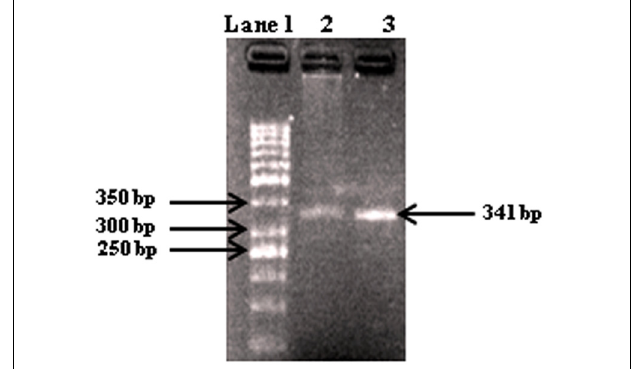
FIGURE 1 | Gel electrophoresis of PCR products with primers AAF2/AAR3 of DNA from fungal isolates. Lane 1, molecular weight markers (1 kb ladder); lanes 2 − 3, Alternaria alternata (341